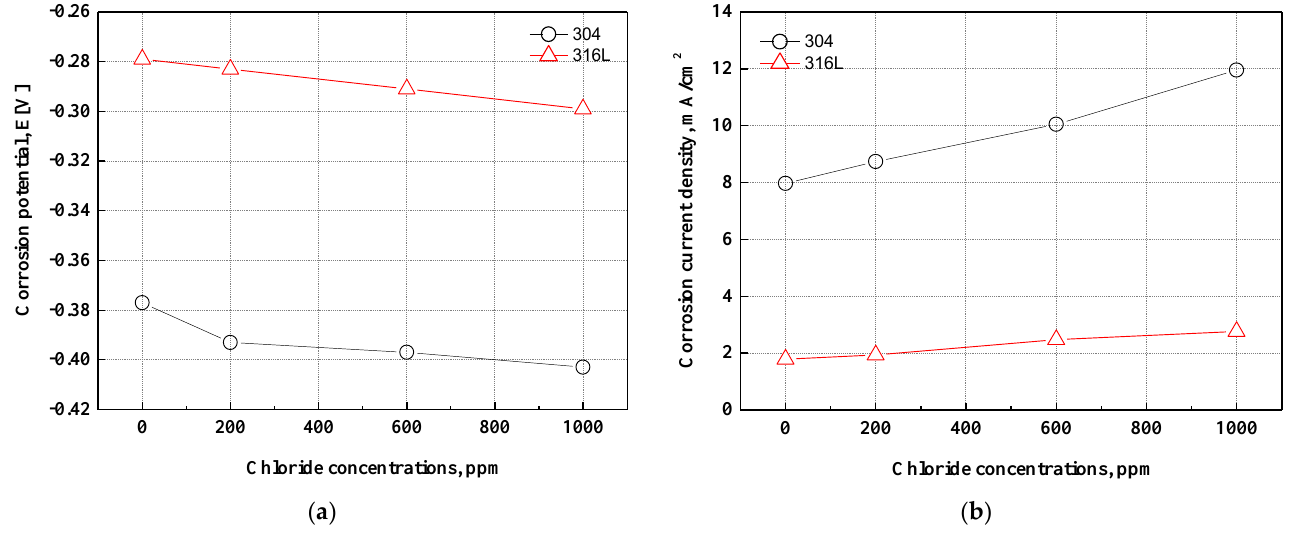
Figure 3. Results of the Tafel extrapolation method for 304 and 316L stainless steels after a potentiodynamic polarization experiment: ( a ) corrosion potential; ( b ) corrosion current density.